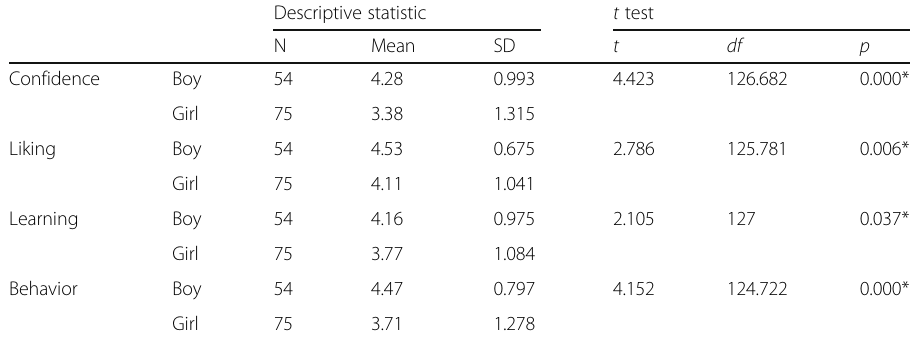
Table 7 Independent t test result for students ’ CGAS score (gender difference analysis) Descriptive